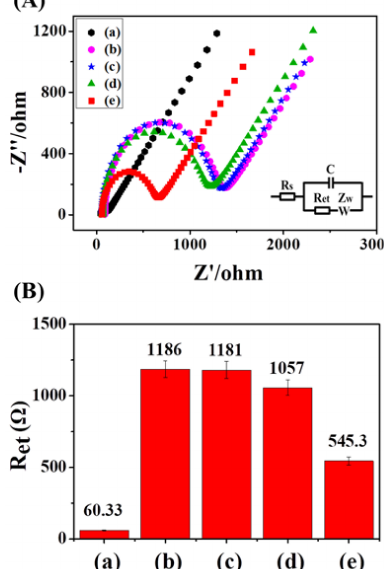
Figure 1. ( A ) Nyquist diagrams from EIS obtained at GCE (a), E1 (b), E2 (c), E3 (d) and E4 (e) in 0.05 M Tris-HCl buffer solution (pH 7.40), containing 0.005 M [Fe(CN) 6 ] 3 − /4 − and 0.20 M KCl. Inset: equivalent circuit used to model impedance data in the presence of redox couples. Rs, C, R et and Z W represent the resistance of the electrolyte solution, the value of capacitance, the interfacial electron-transfer resistance and the Warburg impedance, respectively. The frequency varied from 0.1 to 10 5 Hz, and 5 mV amplitude of the sine voltage signal was used. ( B ) Histograms for the impedance value of at GCE (a), E1 (b), E2 (c), E3 (d) and E4